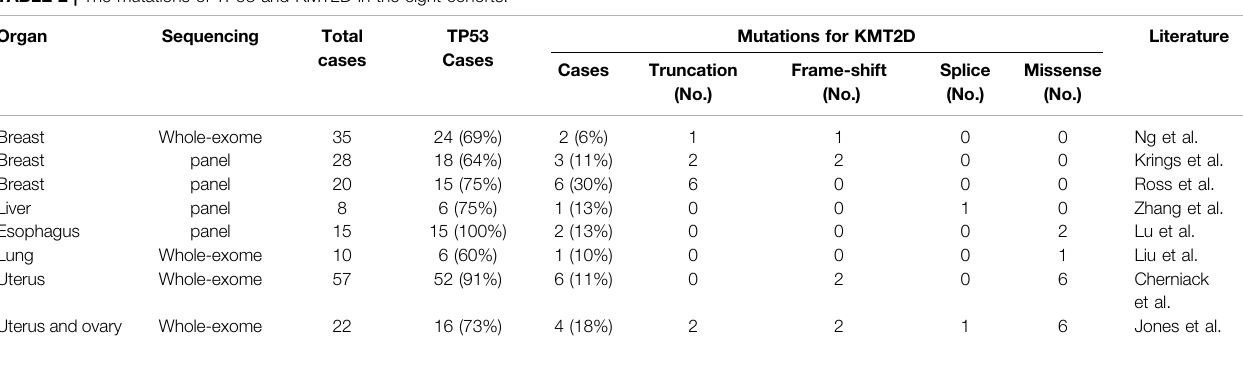
TABLE 2 | The mutations of TP53 and KMT2D in the eight